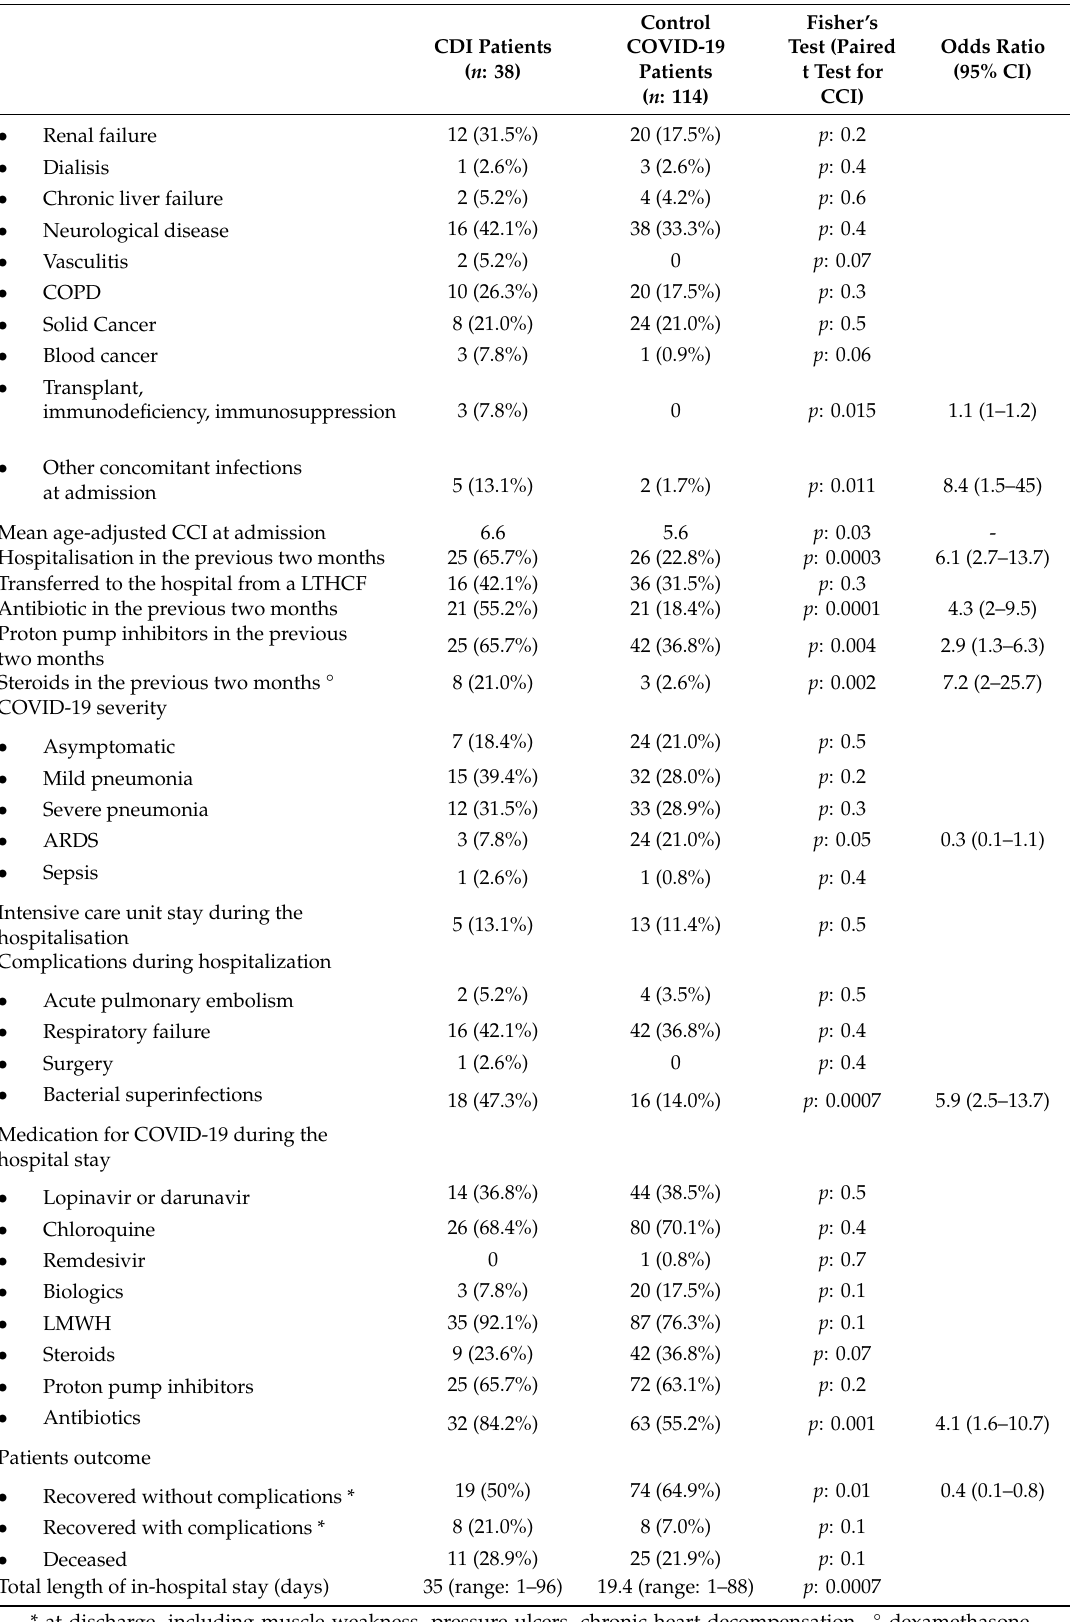
Table 1. Cont. CDI Patients ( n : 38)